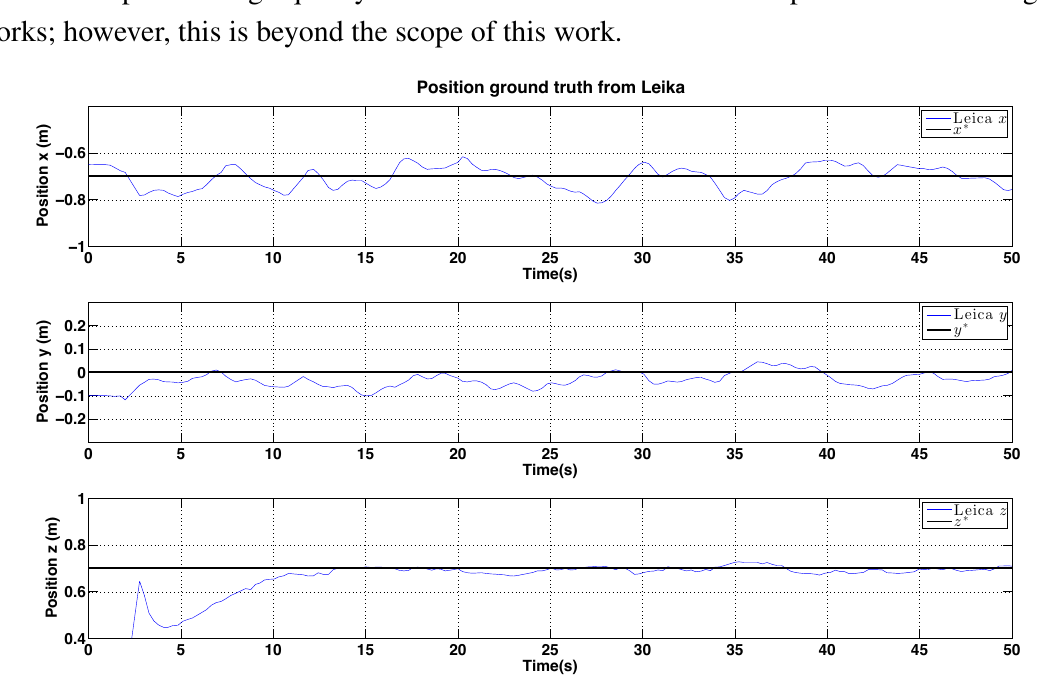
Figure 27. Experimental results for outdoor (night) PBVS-based hovering: control performance. Goal (black) and ground truth states (blue). The desired position for W ˆ x , W ˆ y and W ˆ z is 0.7 m , 0 m and 0.7 m . We compute standard deviations of errors for each − state over the interval 10 s 50 s. σ = 0.047 m , σ = 0.043 m , and σ = 0.016 m x y z ∼